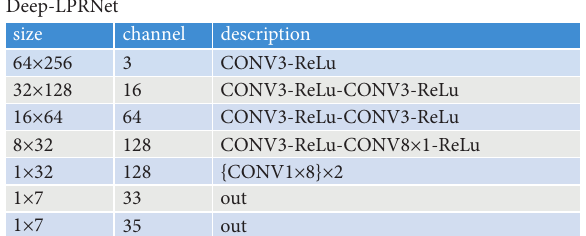
Figure 12: Deep-LPRNet